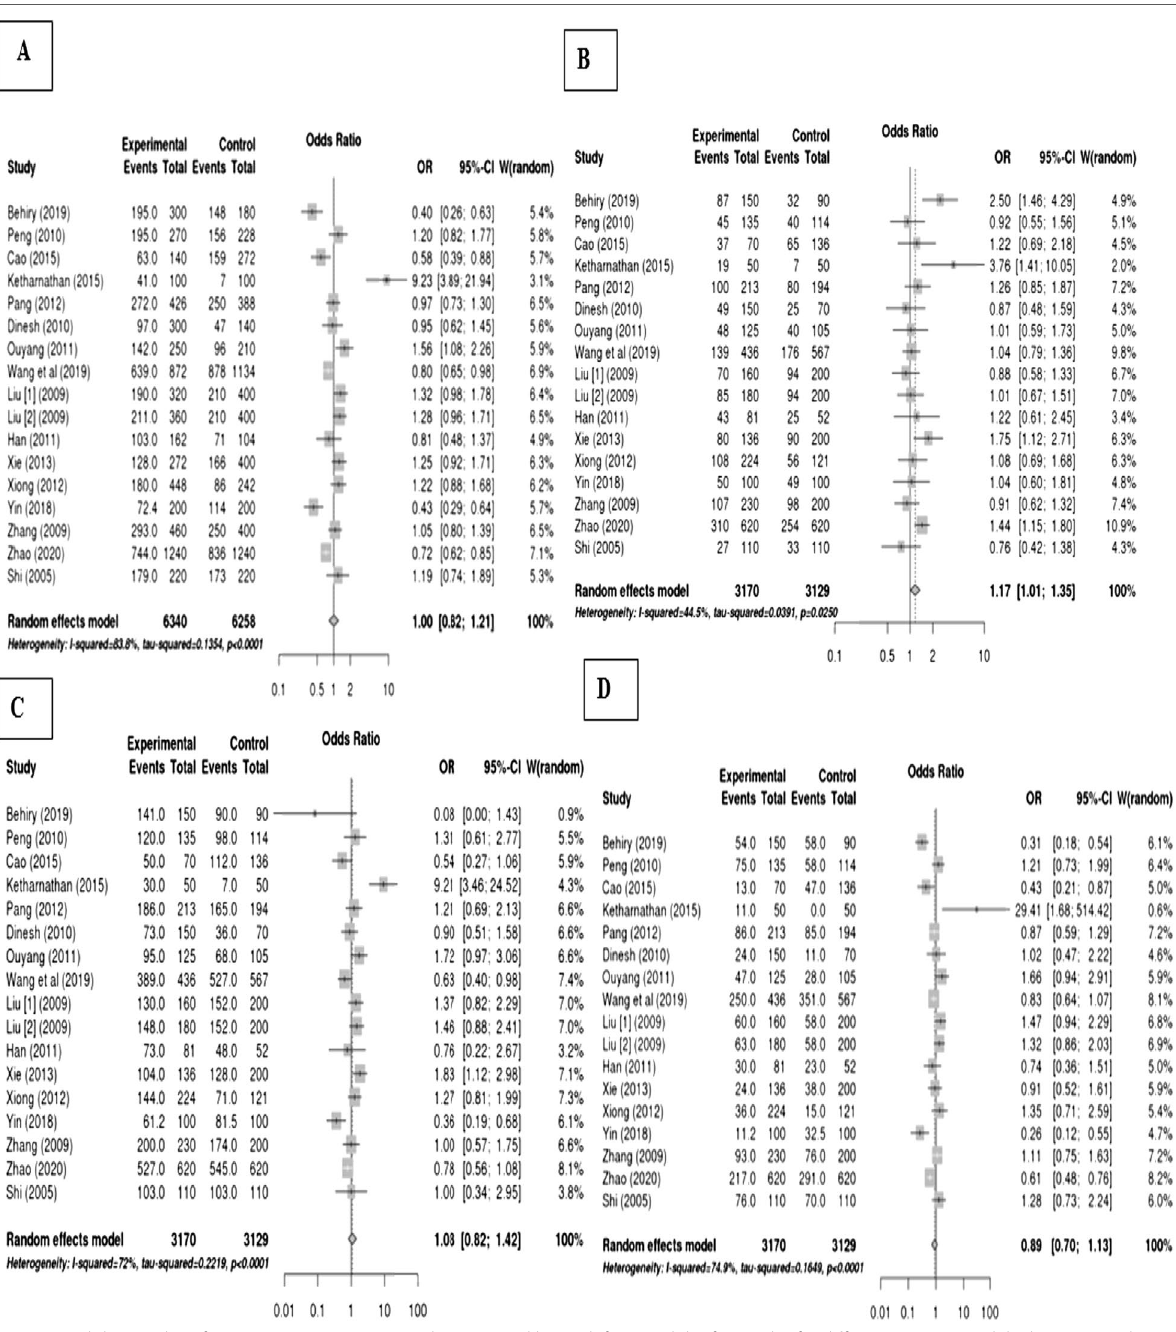
Fig. 2 Final data analysis for rs2277923 association with congenital heart defects and the forest plot for different genetic models showing results as a allelic, b overdominant, c dominant, and d recessive,